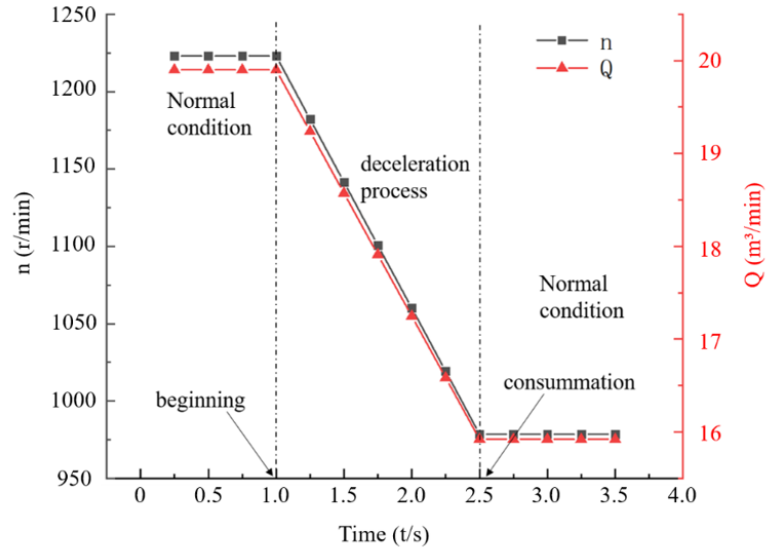
Figure 5. Impeller speed and flow inlet change.